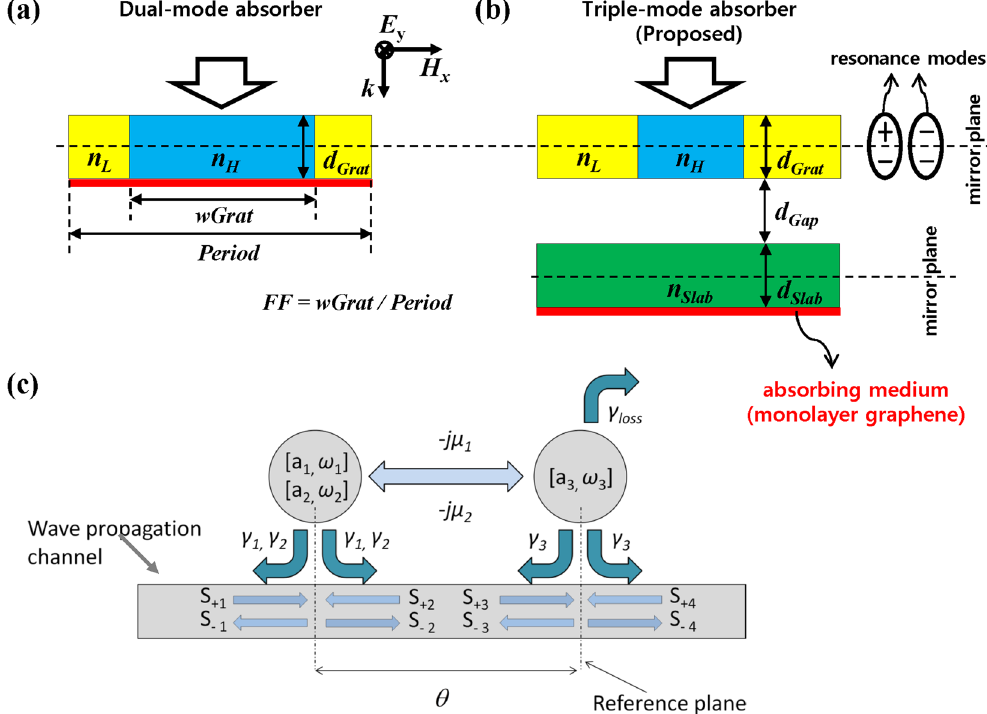
Figure 1. ( a ) Schematic of the previously proposed “ dual - mode absorber ” using an HCG, assuming that n H = 3.0, n L = 1.5, Period = 1.0 μ m, and FF = 0.946 unless otherwise stated. FF is defined as the ratio of higher- index material width ( wGrat ) to Period . ( b ) Schematic of the proposed “ triple - mode absorber ”, assuming that n H = 3.0, n L = 1.5, Period = 0.9 μ m, and FF = 0.43 unless otherwise stated. In both absorbers, the HCG supports two resonance modes with opposite symmetry with respect to the mirror plane perpendicular to the incident light. ( c ) Theoretical model of the proposed “ triple - mode absorber ” for the coupled mode theory analysis, where the slab with a graphene layer is treated as a high-Q resonator (a 3 ) with loss, and the HCG is assumed to support two nondegenerate resonant modes (a 1 and a 2 ) without loss, and both direct and indirect couplings between the HCG and the slab are considered. The red thin layers in ( a ) and ( b ) indicate monolayer graphene of t G = 0.34 nm thickness as an absorbing